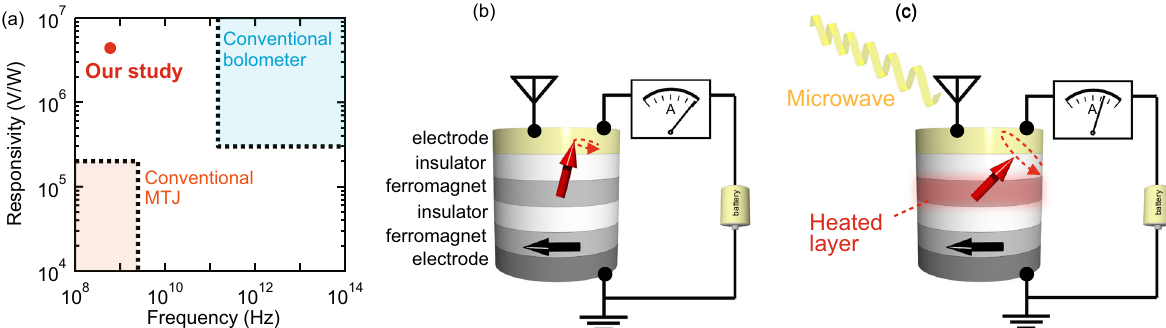
Fig. 1 Positioning of our study in terms of responsivity with respect to the frequency map, and mechanism of the spin bolometer. a Responsivities of recti fi cation devices vs frequency. Blue and orange rectangular regions refer to bolometers and magnetic tunnel junctions (MTJs), respectively. Red point represents our result. b , c Schematic of spin bolometer ( b ) without and ( c ) with applied microwaves. Red and black arrows represent the magnetizations of the ferromagnetic free and pinned layers,